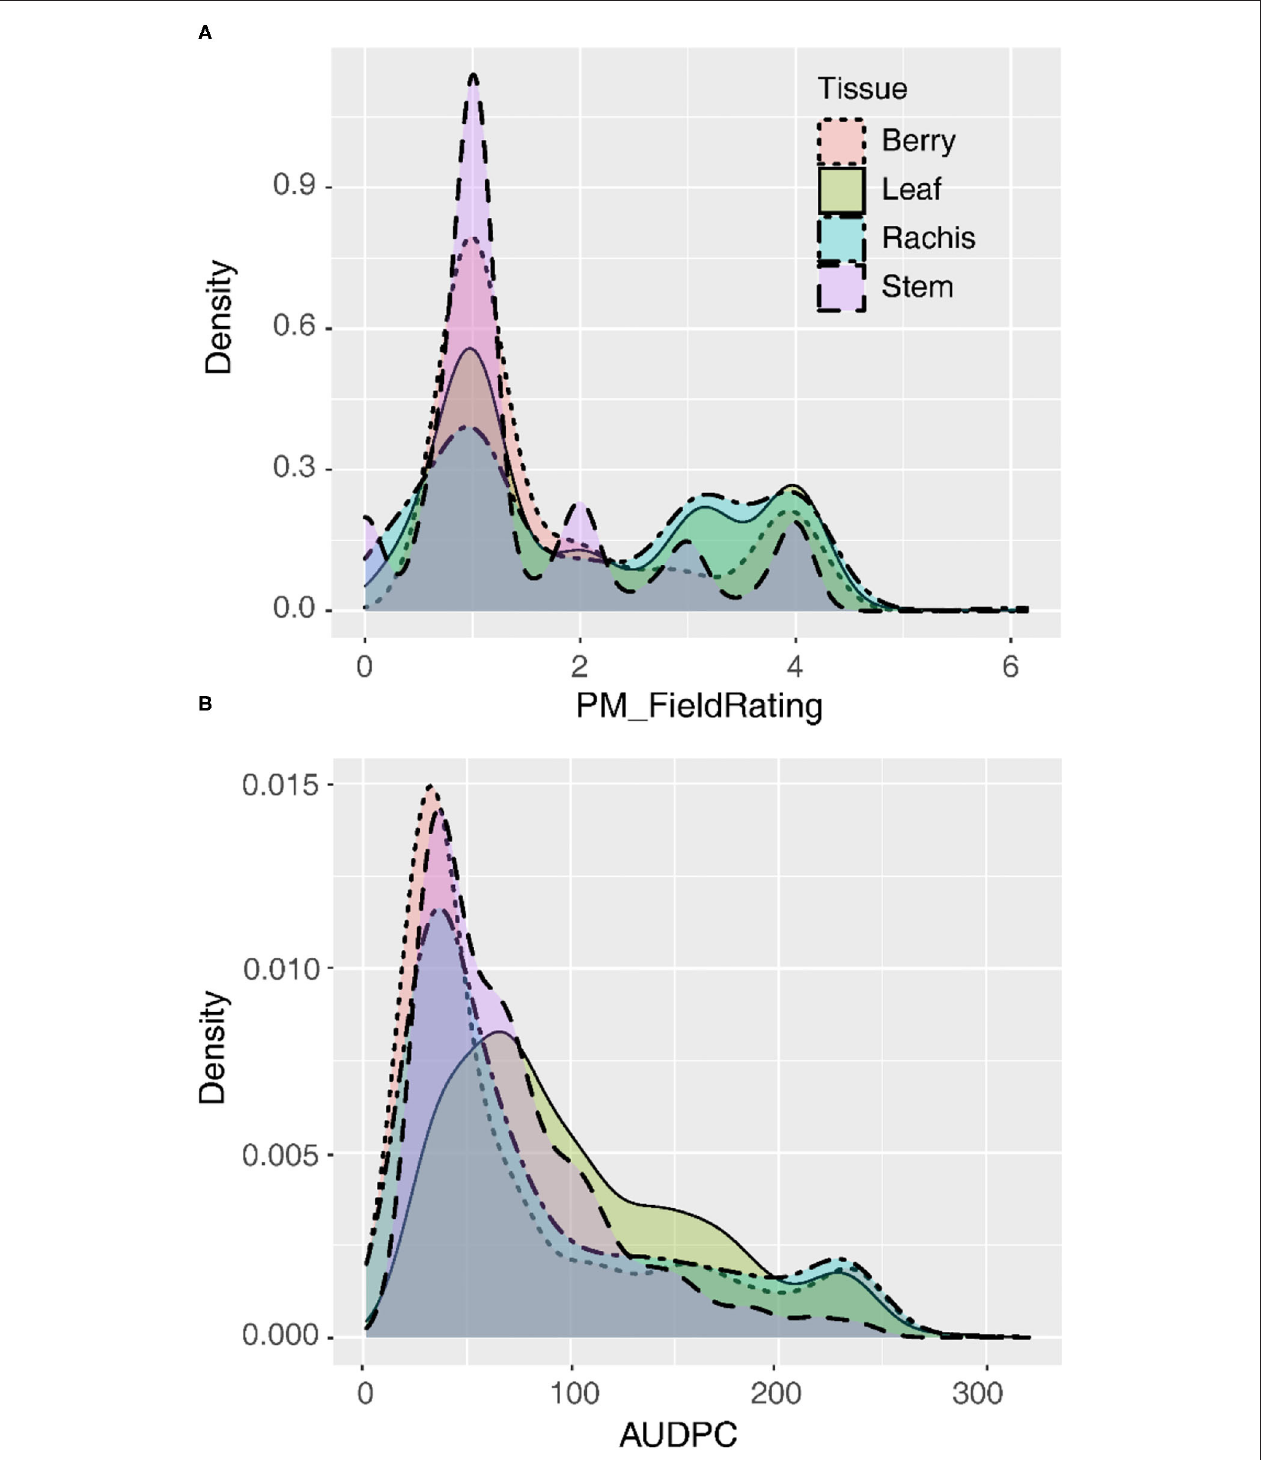
FIGURE 1 | Distribution of disease severity values on four tissues summarized as the best linear unbiased estimates (BLUEs) for (A) qualitative field ratings (1–4) or (B) quantitative area under the disease progress curve (AUDPC).